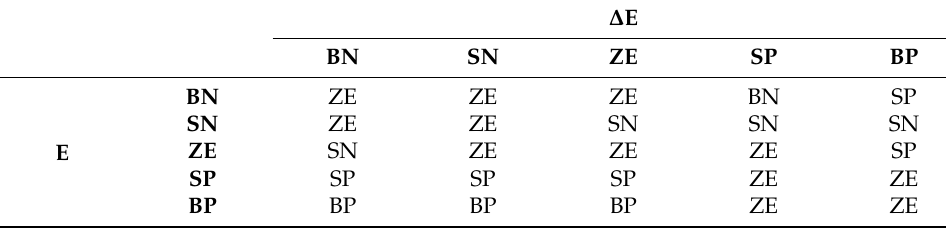
Table 5. Fuzzy rule base.